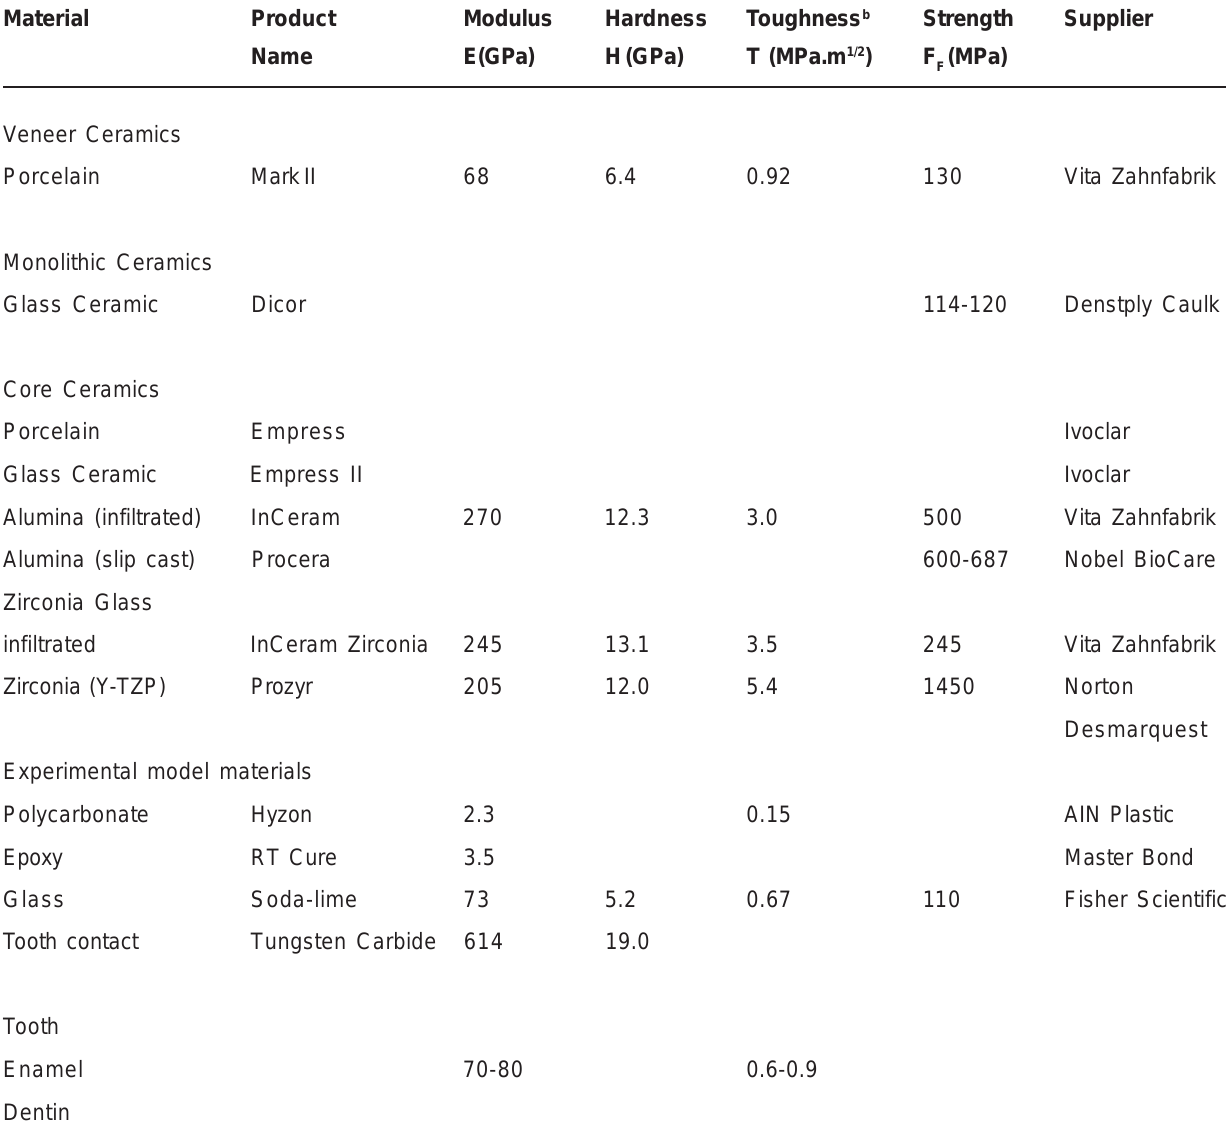
TABLE 1 - Characteristics of some ceramic-based materials